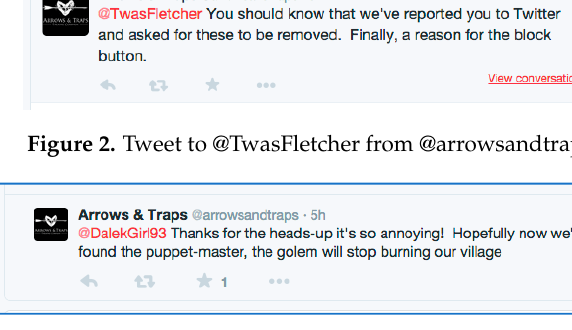
Figure 3. Tweet to @DalekGirl93 regarding @TwasFletcher from @arrowsandtraps.